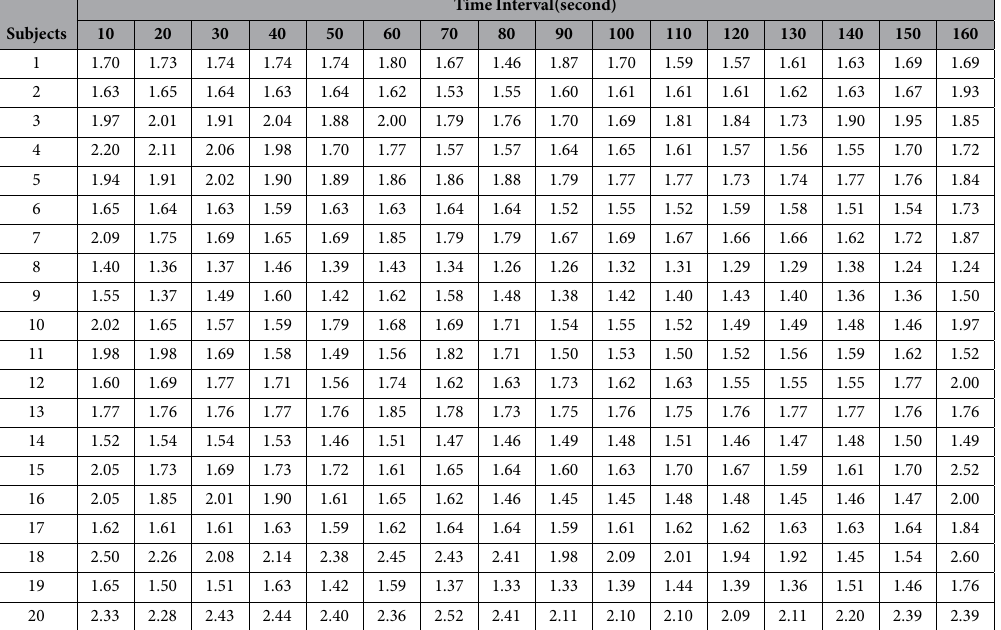
Table 1. Expression energies of 20 subjects, at 10 second